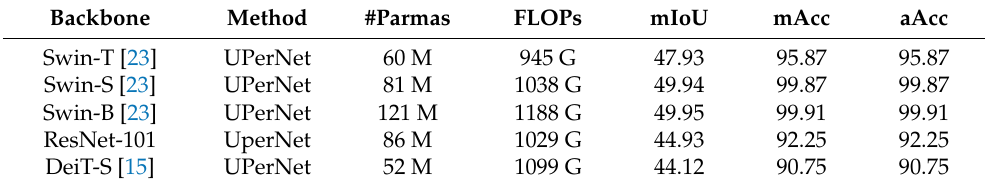
Table 4. Comparison of different backbones in pre-training on MSD segmentation.